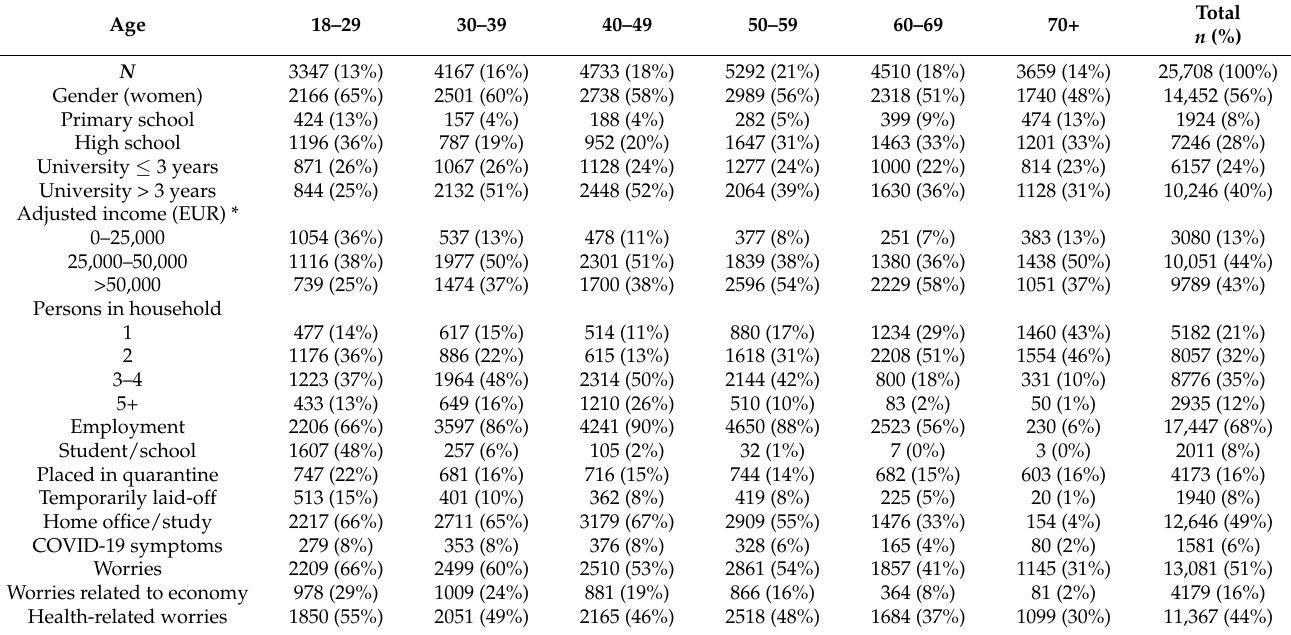
Table 1. Background information about participants per age